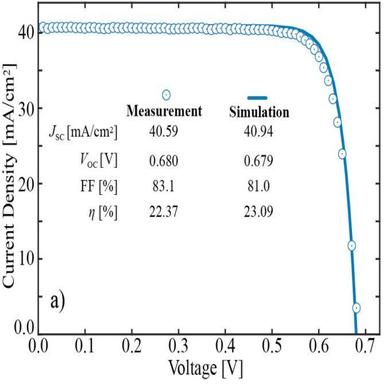
Comparison of the measured and the simulated J-V characteristics under STC.